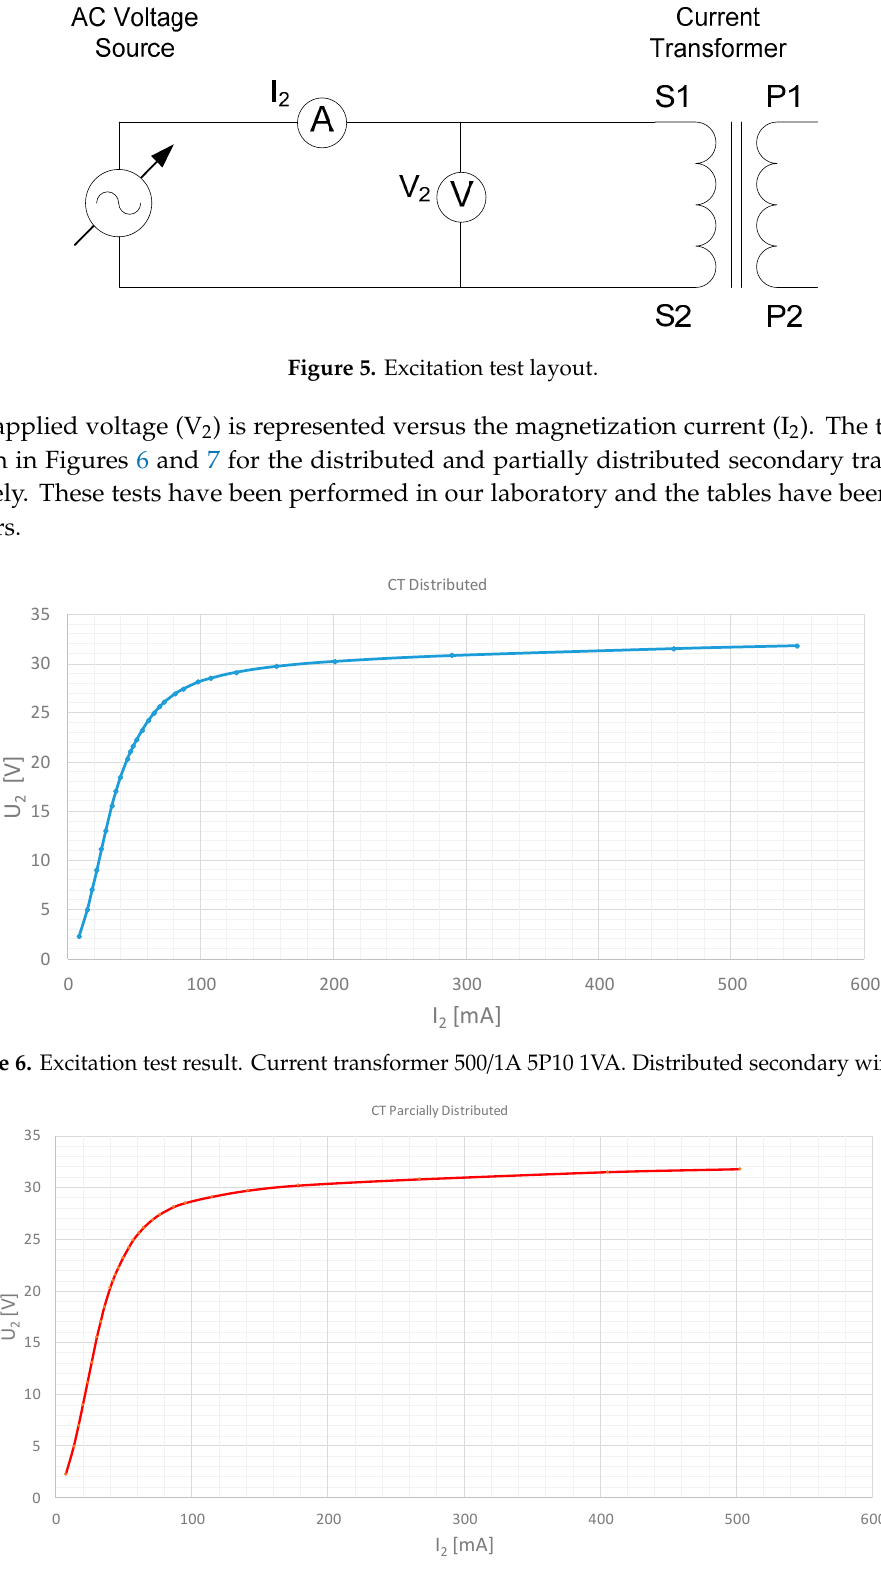
Figure 7. Excitation test result. Current transformer 500 / 1A 5P10 1VA. Partially distributed secondary